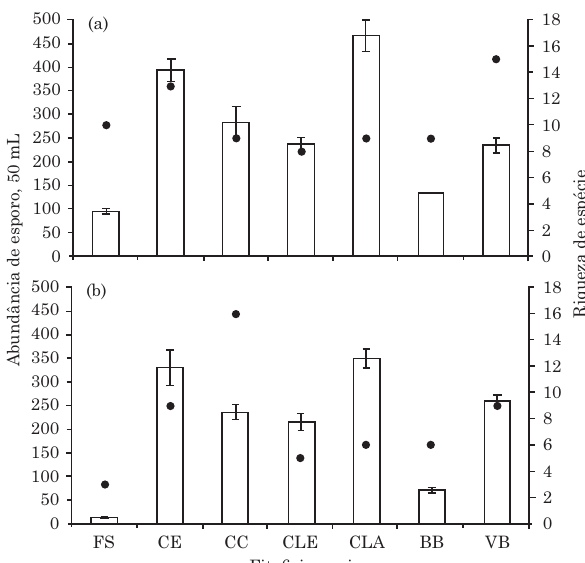
Figura 3. Abundância de esporos (barras) e riqueza de espécies (ponto) de FMA encontrados nos dois períodos de coleta, nas diferentes fitofisionomias (FS: floresta semidecídua;